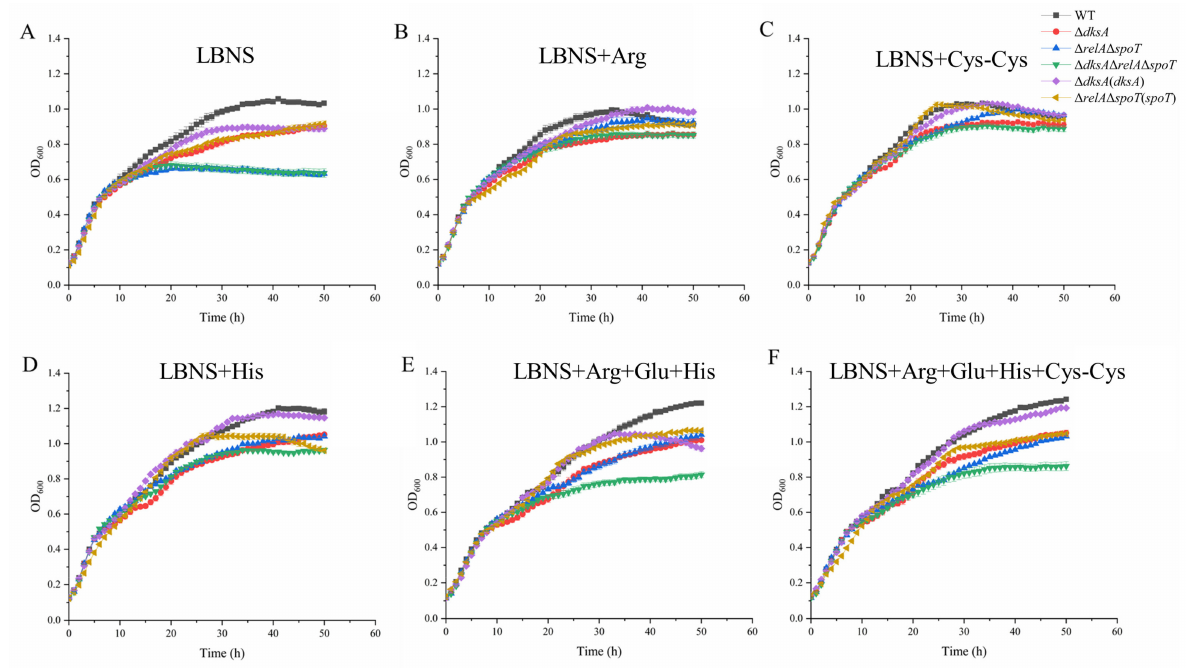
Figure 6. Growth characteristics of WT and mutant strains in liquid medium. ( A ) LBNS; ( B ) LBNS supplemented with 1.16 g/L arginine; ( C ) LBNS supplemented with 0.1 g/L cystine; ( D ) LBNS supplemented with 1.28 g/L histidine; ( E ) LBNS supplemented with 0.38 g/L arginine, 1.31 g/L glutamic acid, and 0.42 g/L histidine; ( F ) LBNS supplemented with 0.29 g/L arginine, 0.1 g/L cystine, 0.98 g/L glutamic acid, and 0.32 g/L histidine. The data are the means OD 600 for five independent cultures and the standard errors of the